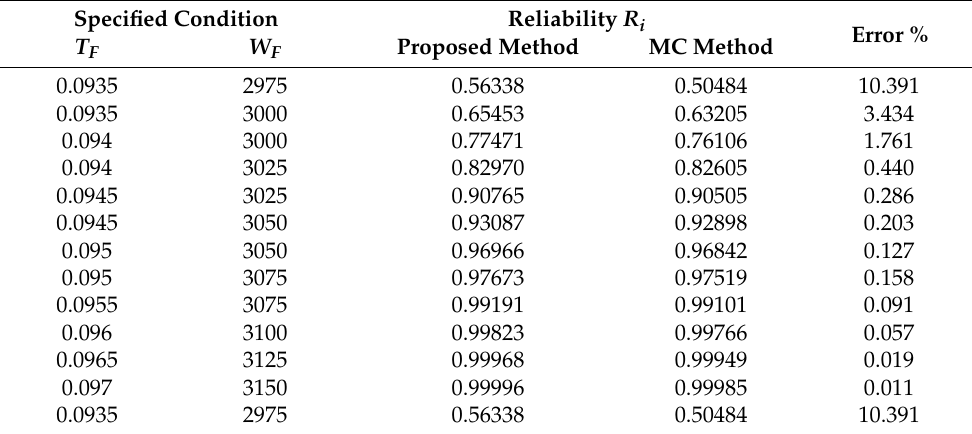
Table 3. Comparison of